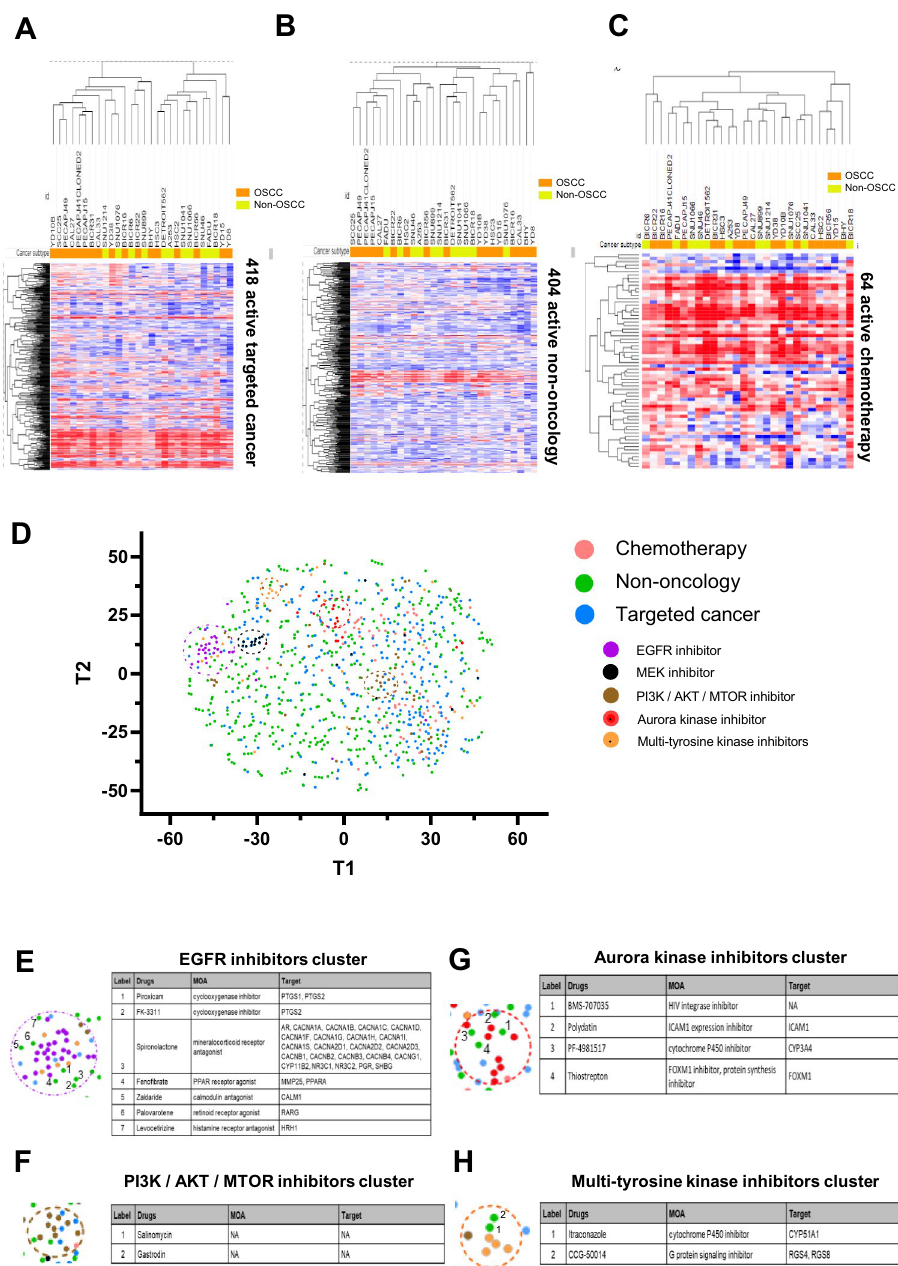
Figure 2. Visualization of drug response data using heatmap with hierarchical clustering and t-distributed stochastic neighbour embedding (tsne) analysis. Heatmap of drug response data from the PRISM primary screen on the 28 HNSCC cell lines, for ( A ) 418 active targeted cancer compounds; ( B ) 404 active non-oncology compounds; ( C ) 64 active chemotherapies. Heatmaps were plotted using Morpheus tool: https:// softw are. broad insti tute. org/ morph eus/. ( D ) High-dimensional reduction of drug response data of 886 active drugs in HNSCC was performed using tsne analysis (perplexity 30, iterations 100). Targeted cancer compounds that belong to the same top MOA classes such as PI3K/AKT/MTOR inhibitors, EGFR inhibitors, MEK inhibitors and Aurora kinase inhibitors cluster closely together. While generally the non-oncology compounds are very scattered across the plot, reflecting the likely diversity of MOAs. ( E )–( H ) Non-oncology compounds that consistently fall into the ( E ) EGFR inhibitor cluster, ( F ) PI3K/AKT/MTOR inhibitor cluster, ( G ) Aurora kinase inhibitor cluster and ( H ) Multi-tyrosine kinase inhibitor